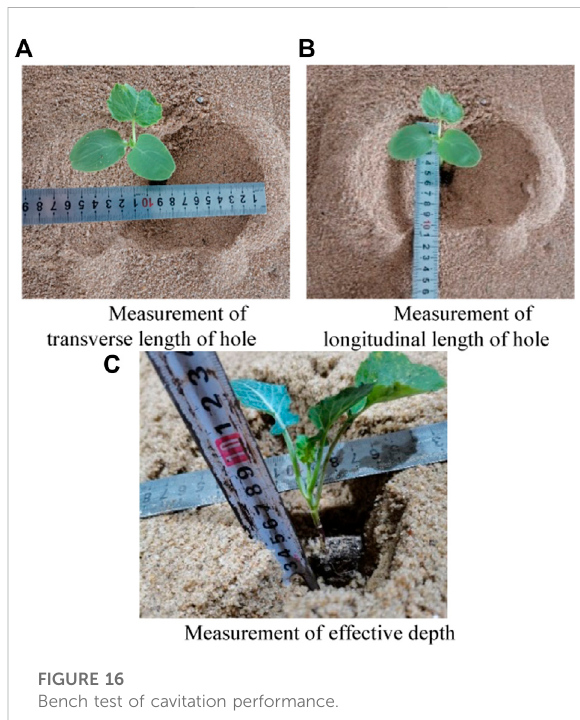
FIGURE 16 Bench test of cavitation